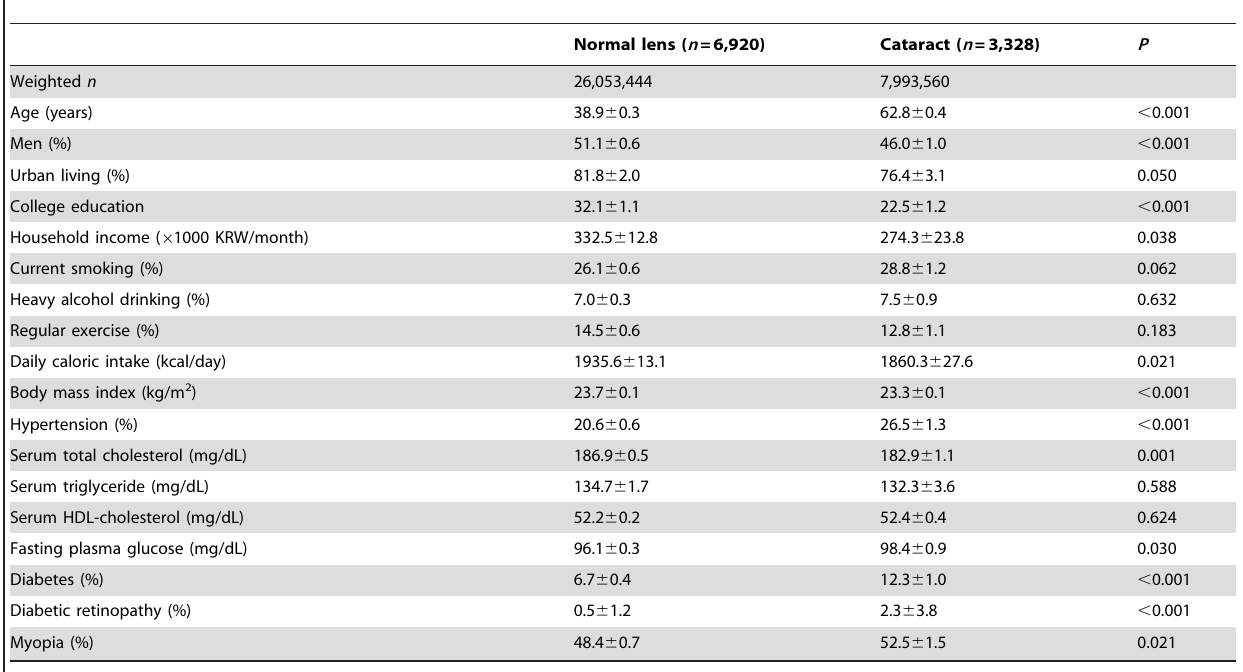
Table 2. Age- and gender-adjusted clinical characteristics by the presence of lens opacity.